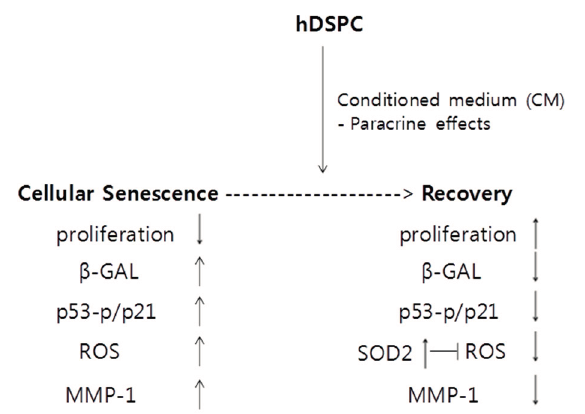
Figure 6. A schematic representation of the mechanism contributing to the beneficial effects of hDSPC-CM on senescent human dermal fibroblasts. ↑ means increase, whereas ↓ means